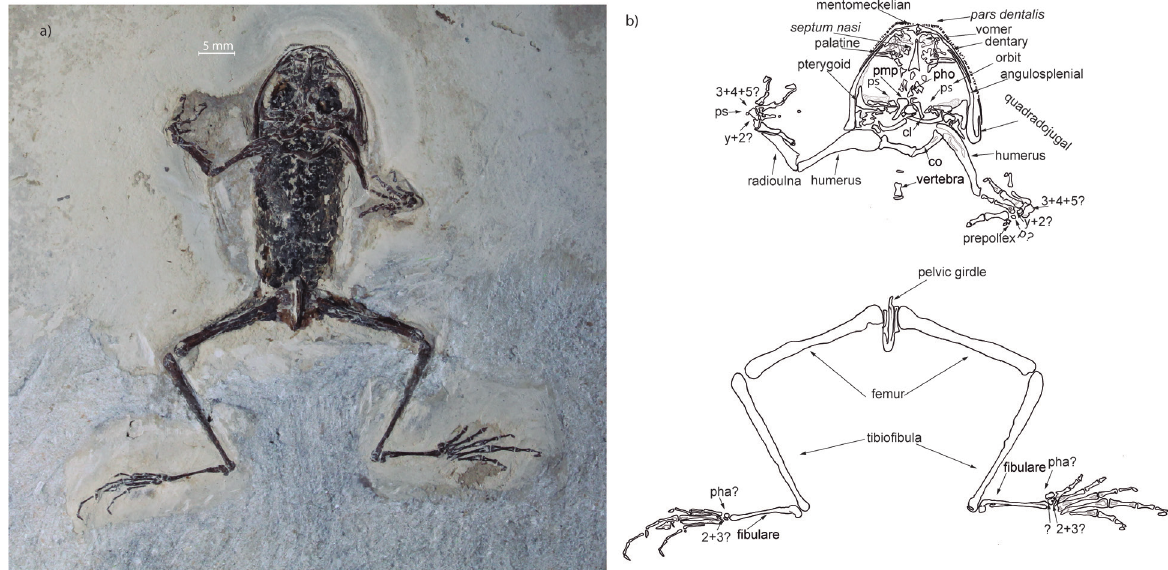
Figure 1. Primaevorana cratensis, holotype (GP/2E-9497) from Crato Formation, Lower Cretaceous (Aptian), region of Nova Olinda, Araripe Basin, Ceará state, Northeastern Brazil. a) Photograph by Luiz E. Anelli; b) Illustration of the fossil. Abbreviations: pmp: posteromedial processes of the hyoid; pho: parahyoid ossification; ps: parasphenoid; 3+4+5: distal carpals 3+4+5; ps: palmar sesamoid; y+2: element y + distal carpal 2; p: proximal element of the prepollex; 2+3: distal tarsals 2+3; pha: